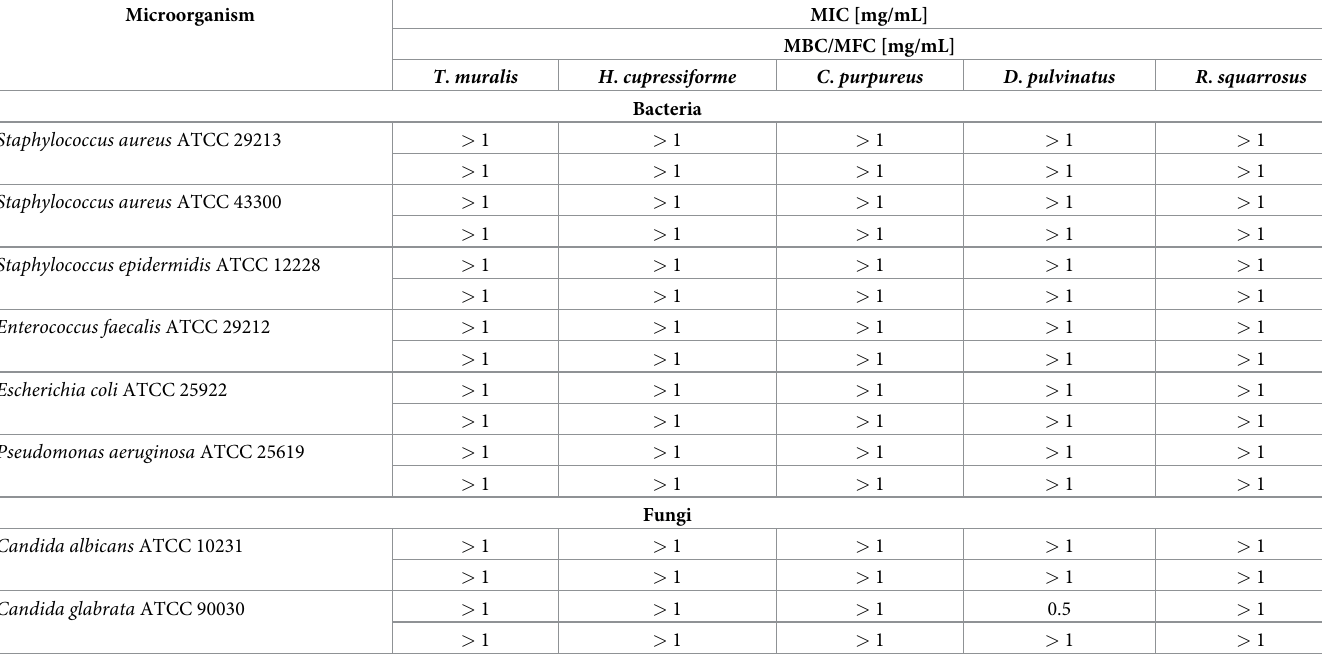
Table 1. The antimicrobial activity of mosses extracts.